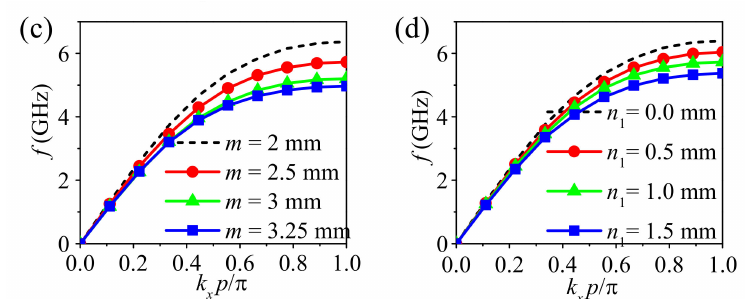
Figure 2. The dependence of the dispersion relations on the geometric parameters of the windmill- shaped SSPP unit. ( a ) Terahertz windmill-shaped SSPP unit’s dispersion relations for m when n 1 is fixed at 1 µ m; ( b ) terahertz windmill-shaped SSPP unit’s dispersion relations for n 1 when m is fixed at 2.5 µ m; ( c ) microwave windmill-shaped SSPP unit’s dispersion relations for m when n 1 is fixed at 1 mm; ( d ) microwave windmill-shaped SSPP unit’s dispersion relations for n 1 when m is fixed at 2.5 mm.